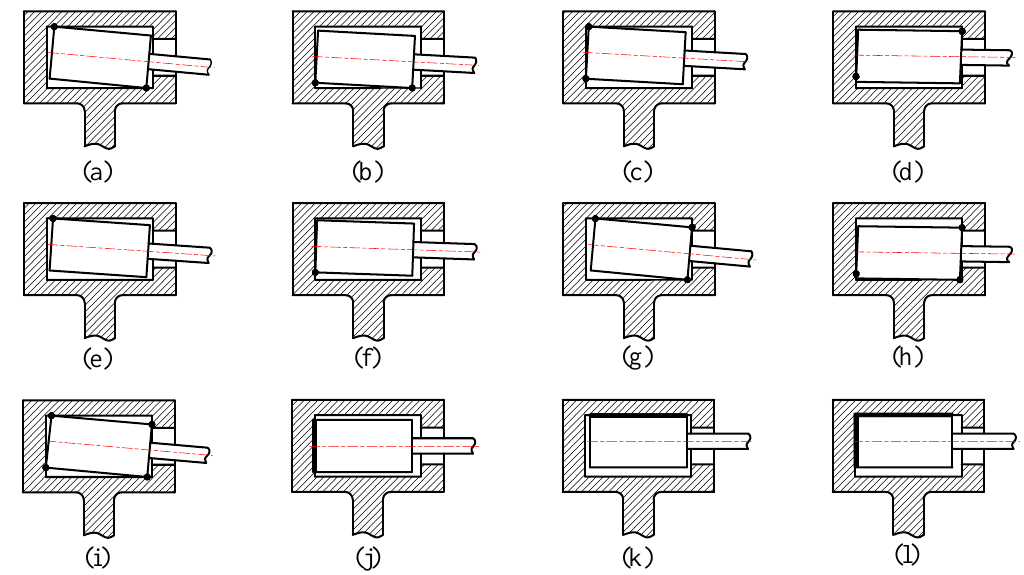
Figure 2. Possible contact forms between the bearing and journal. ( a – d ) Two-point contact forms; ( e , f ) single-point contact forms; ( g , h ) three-point contact forms; ( i ) four-point contact form; ( j ) surface contact form; ( k ) line contact form; and ( l ) both surface contact and line contact forms.